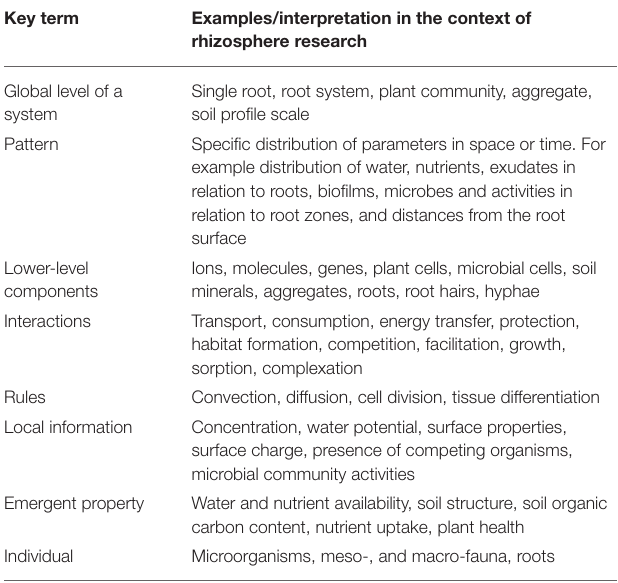
TABLE 1 | Key terms related to principles and tools of self-organization, referring to the definition by Camazine et al. (2003). Key